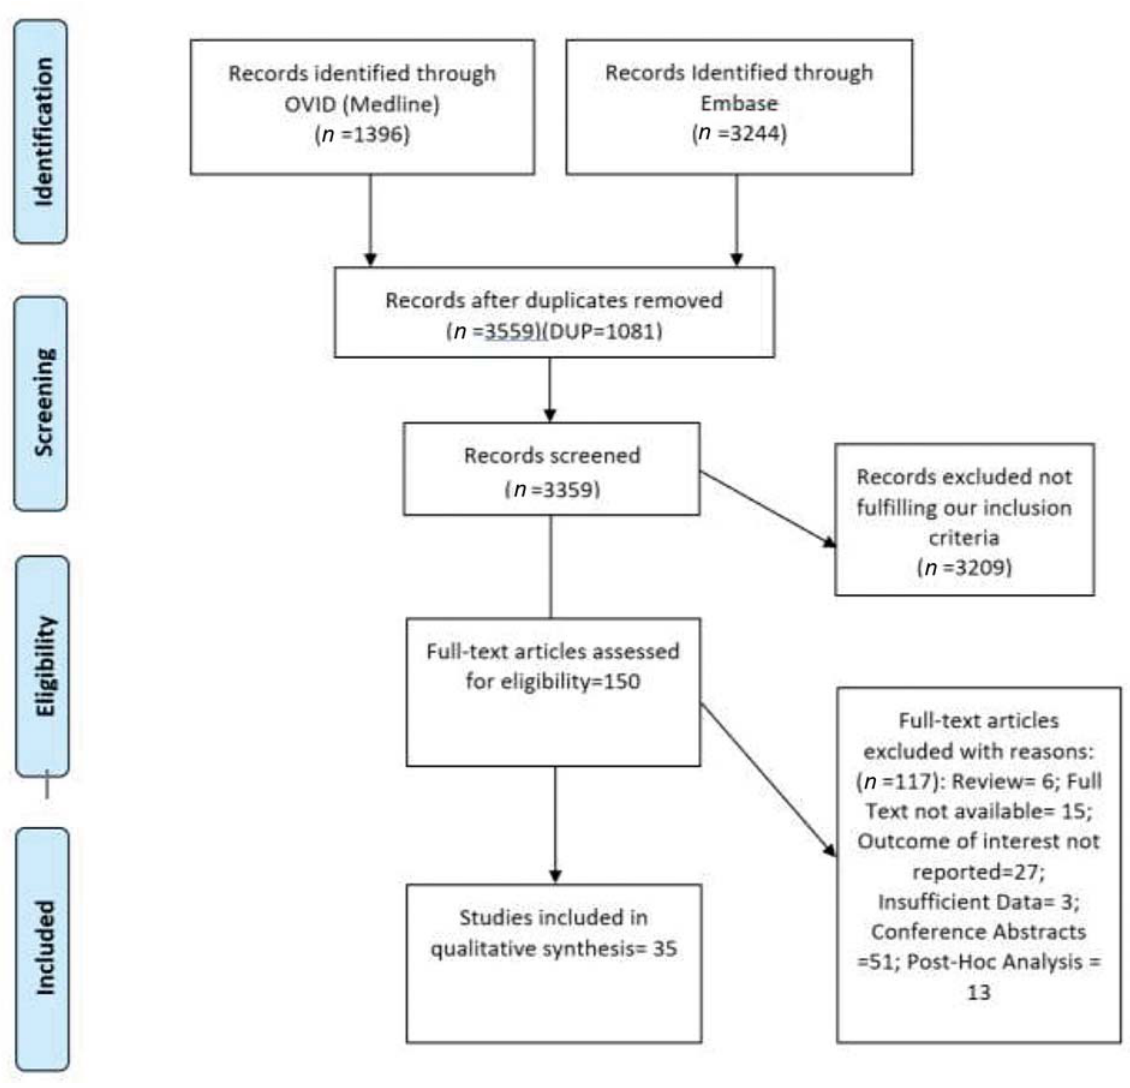
Fig. 1 PRISMA (Preferred Reporting Items for Systematic Reviews and Meta-Analyses) fl ow diagram summarizing the identi fi cation process of relevant